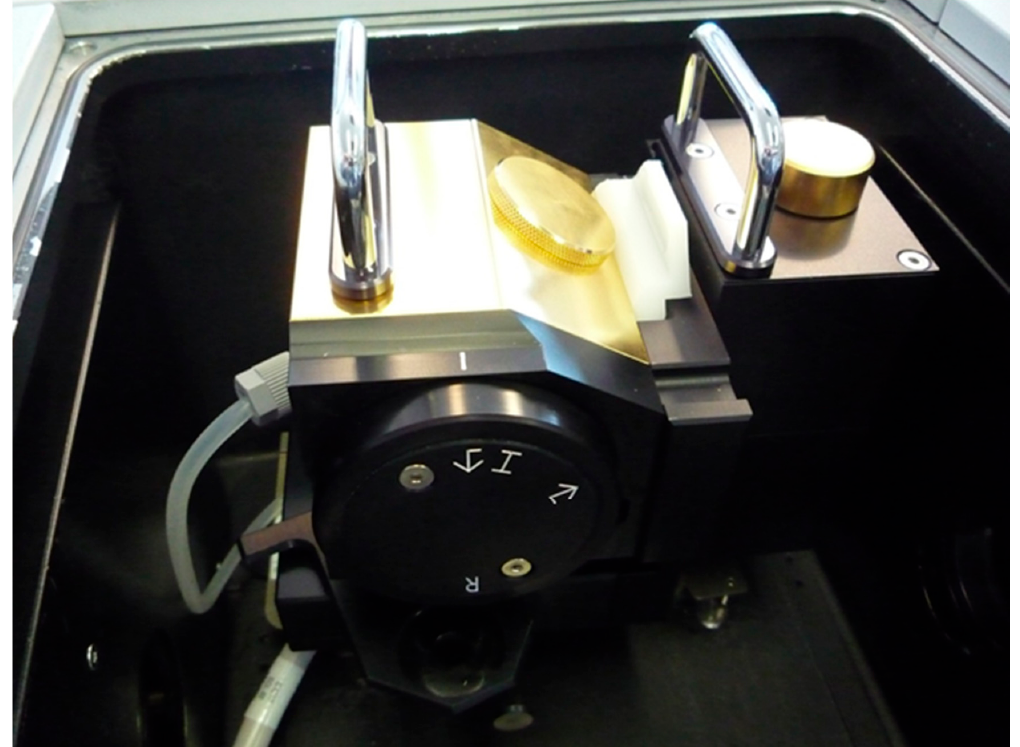
Figure A8. Gold coated integrating sphere and reference used for the experiment at PSL (German Aerospace Center (DLR)).